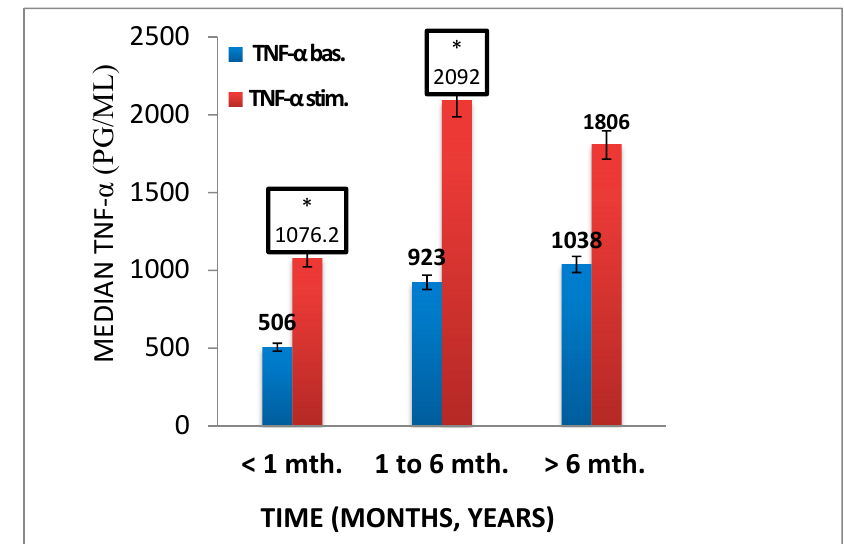
Figure 5. pro-inflammatory activation cytokine TNF- α in patients with chronic foot ulcers ( n = 42) of various duration (< 1 to ≥ 6 months (mth). There were 12 patients with less than 1 month of duration, 17 patients with 1 to less than 6 months of duration, and 13 patients with more than 6 months of ulcer duration. Bar histograms display median values, and whiskers reflect IQR (Q25; Q75). Significance level using the Kolmogorov–Smirnov test and Mann–Whitney test, * p < 0.05.